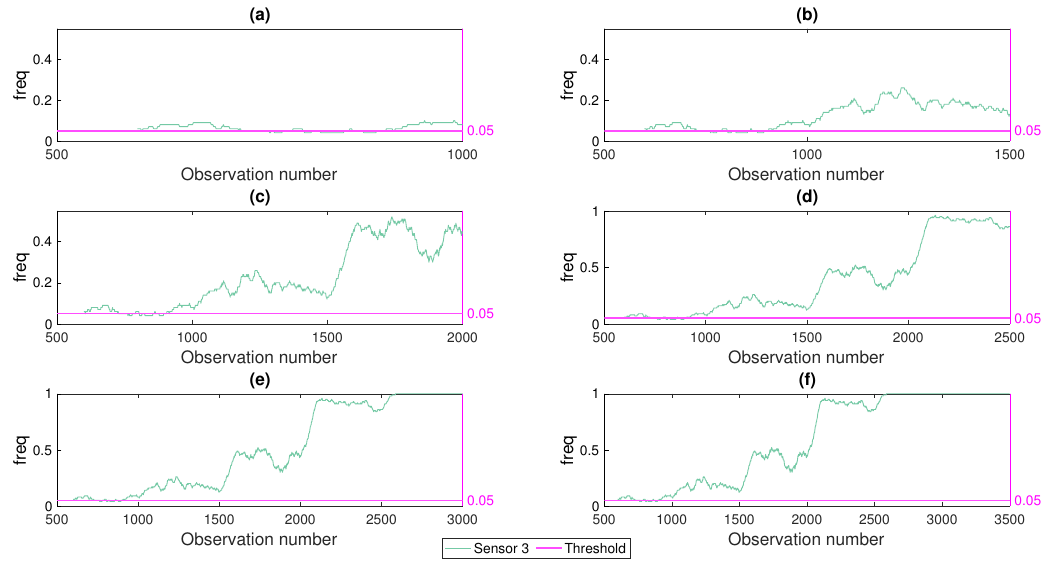
Figure 12. Development of the frequency parameter with damage and observation number for sensor number 3. Subplots ( a – f ) show the development of the scatter plot from the first 1000 observations to 3500 observations. The line at 0.05 for all cases indicates the frequency threshold for acceptable false alarm